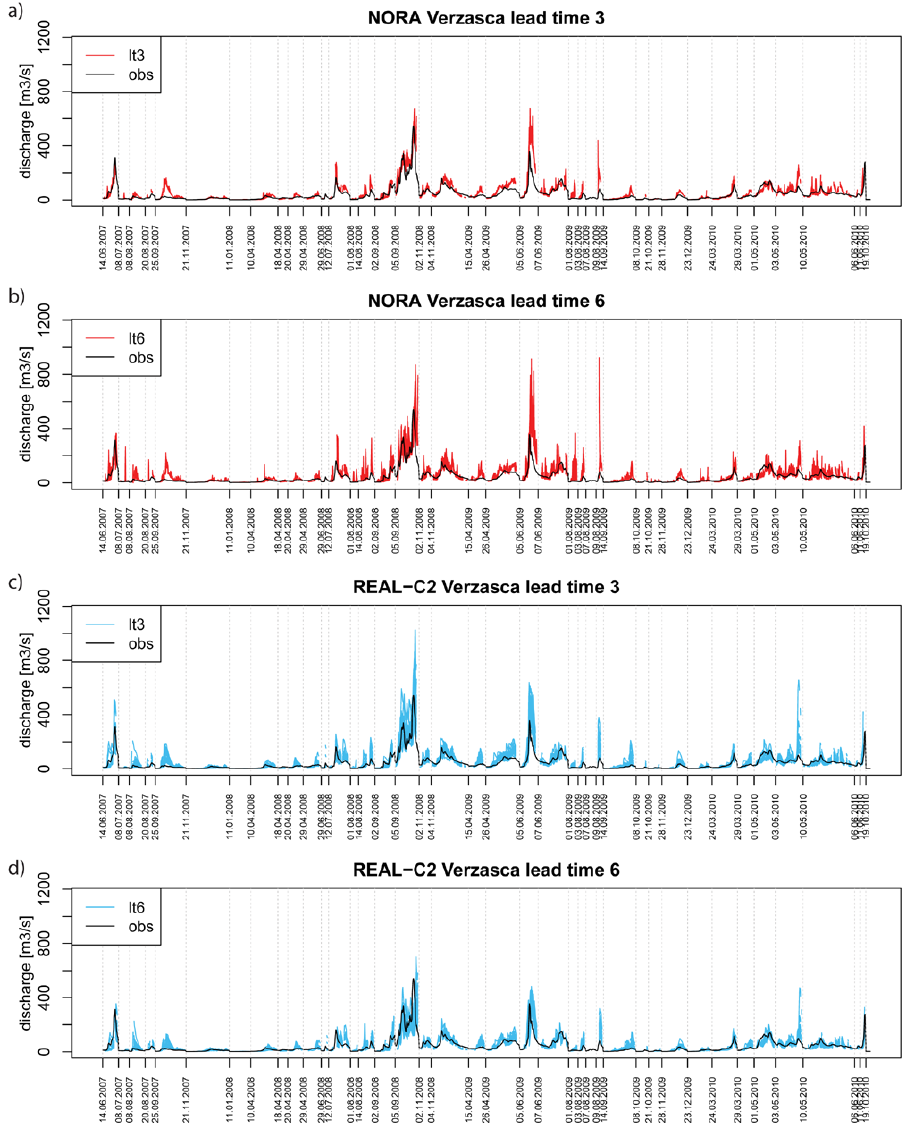
Fig. 3. NORA and REAL-C2 discharge ensemble for the Verzasca River for all 40 events in the study period. The panels (a) and (c) show the discharge ensembles at 3h lead time, and the panels (b) and (d) show the discharge ensembles at 6h lead time. The individual events are separated by dashed vertical lines. The dates given in the x axis refer to the date of the beginning of each